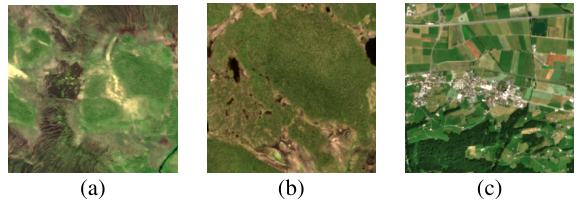
Figure 4. Conversion of pixel-level binary annotations into single-label scene annotations. Patches with more than 80% of Figure 3. Three example images from the dataset: (a) positive wilderness pixels receive label wilderness (left). Patches with example indicating a wilderness area; (b) hard negative example relatively similar shares of wilderness and non-wilderness pixels extracted in the vicinity of a wilderness area; (c) easy negative are removed (center). Patches with less than 20% of wilderness extracted from a populated area in Europe. pixels received the scene label non-wilderness